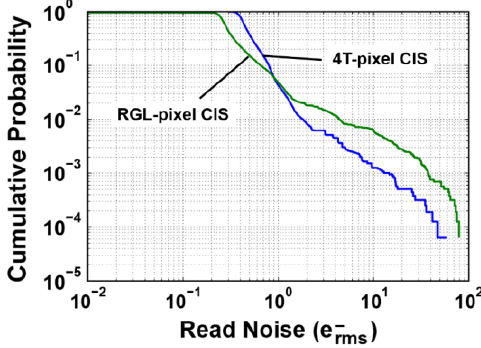
Figure 17. Cumulative probability plots of noise in the RGL-pixel CIS and 4T-pixel CIS.